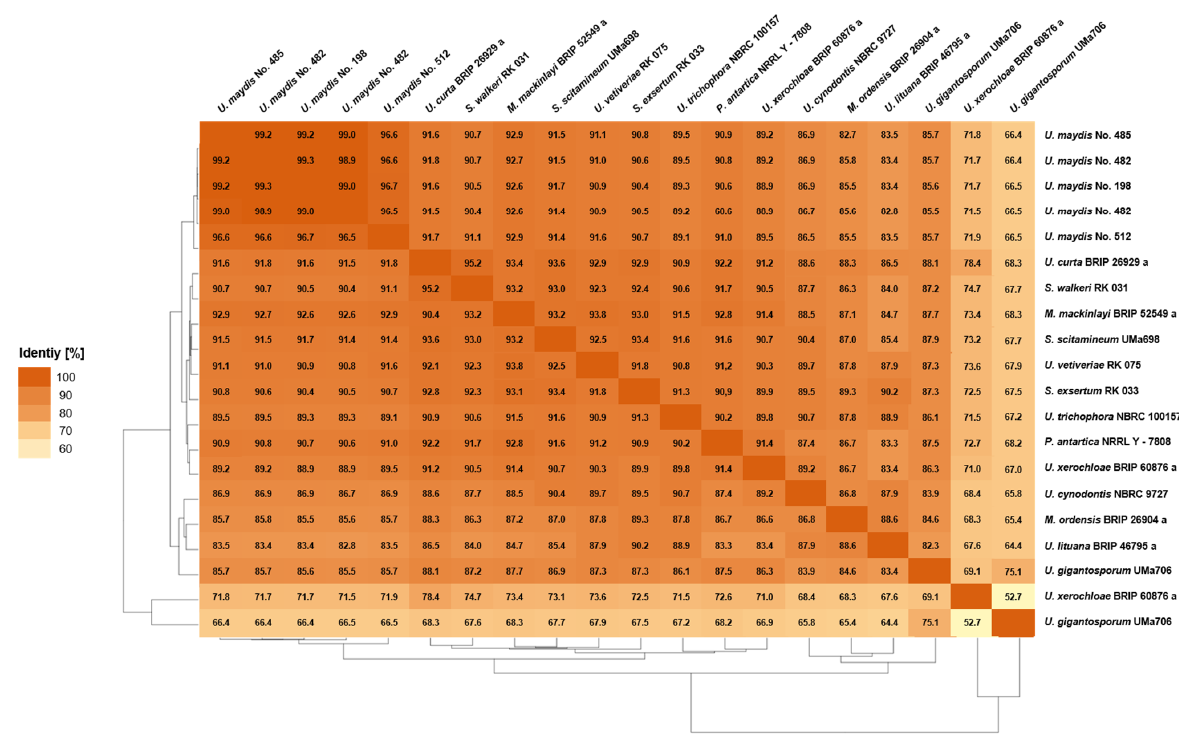
Figure 2. Pairwise Percentage of Conserved Proteins (POCP) analysis for members of the Ustilagi- naceae family. The conserved proteins between a pair of genomes were determined by aligning all the protein sequences of one genome (query genome) with all the protein sequences of another genome using the BLASTP program [38]. Proteins from the query genome were considered conserved when they had a BLAST match with an E-value of less than 1 × 10 −5 , a sequence identity of more than 40%, and an alignable region of the query protein sequence of more than 50% [38]. Two isolates were sequenced in case of U. maydis No. 482 and U. gigantosporum UMa706.